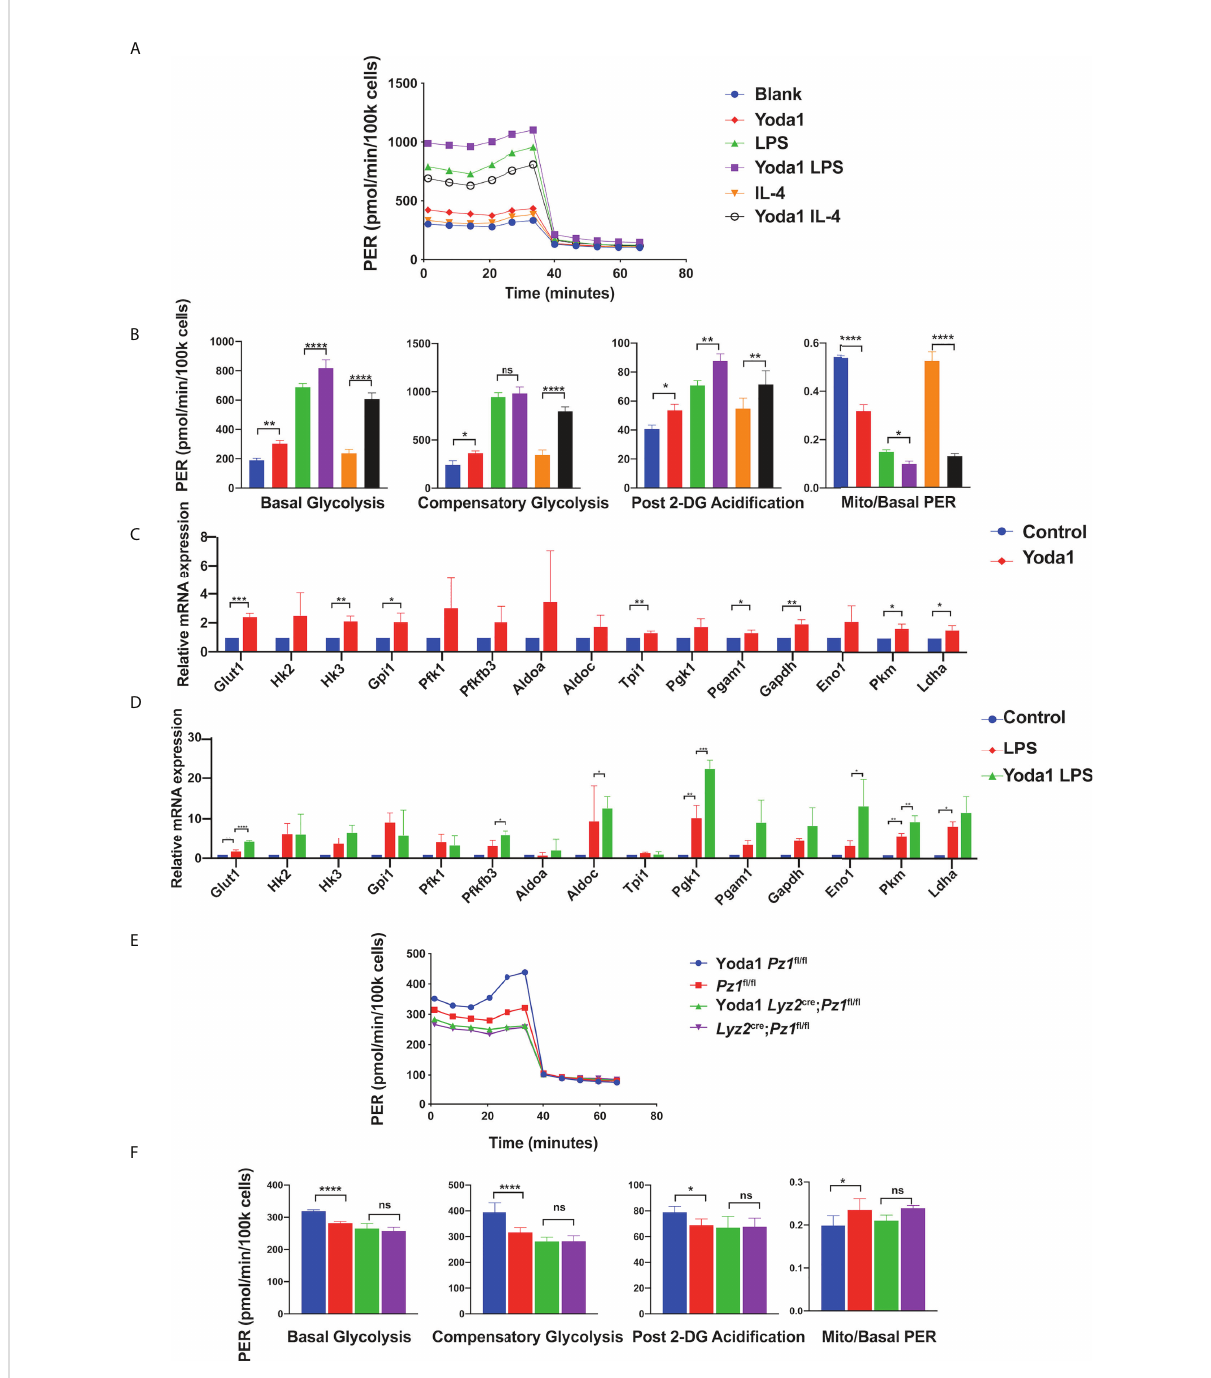
FIGURE 3 Yoda1 induces glycolysis in macrophages. (A, B) Glycolytic rate assay pro fi le and glycolytic analysis of BMDMs pretreated with 10 µM Yoda1 or DMSO, incubated in the indicated conditions (blank; 10 ng/ml LPS for 24 h; 10 ng/ml IL4 for 24 h) (n = 4) (C) The mRNA expression of glycolysis-related genes treated with 10 µM Yoda1 or DMSO for 30 min (n = 3). (D) The mRNA expression of glycolysis-related genes pretreated with 10 µM Yoda1 or DMSO for 30 min and 10 ng/ml LPS for 2 h (n = 3). (E, F) Glycolytic rate assay pro fi le and glycolytic analysis of the BMDMs from Lyz2 cre/+ Piezo1 fl ox/ fl ox mice and Piezo1 fl ox/ fl ox control mice pretreated with or without 10 µM Yoda1 for 30min (n = 7). Statistical signi fi cances were calculated using (B, D, F) one-way ANOVA, Tukey ’ s multiple comparisons test; (C) two-tailed Student t test. Data expressed as means ± SD. *P < 0.05, **P < 0.01, ***P < 0.001; **** P < 0.0001, ns, not signi fi cant. BMDMs, bone marrow-derived macrophages; Lyz2 cre/ + Piezo1 fl ox/ fl ox , conditionally Piezo1-de fi cient mice; IL, interleukin; TNF- a , tumor necrosis factor a ; LPS,